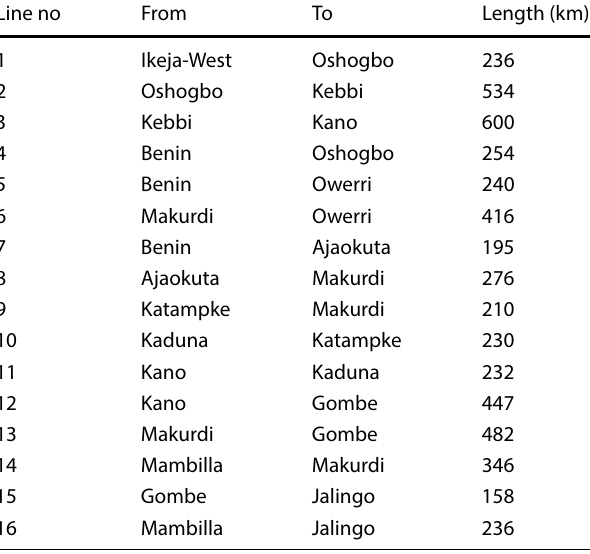
Fig. 1 Map of the Nigerian 750-kV grid [20] Table 1 Line name and length as mapped out from super grid map Line